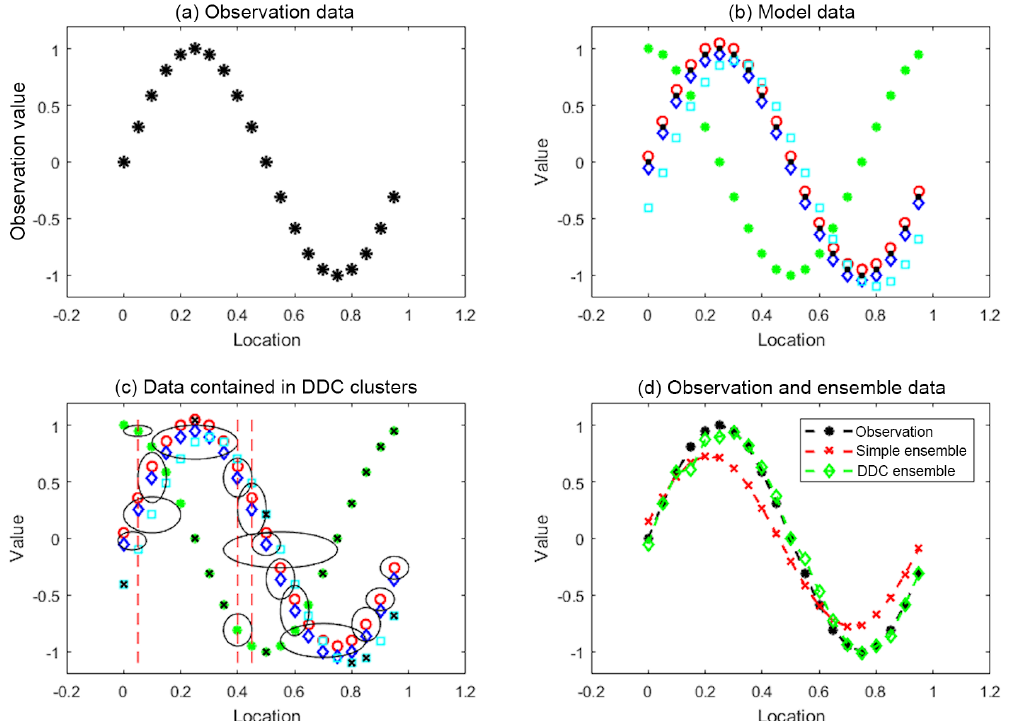
Figure 1. Principles of the ensemble clustering method illustrated using a synthetic data set. (a) A synthetic spatially varying observation (X). (b) Predictions of X from four idealised models (see main text). (c) Cluster analysis of the model data sets using the DDC clustering algorithm. Ellipses represent the different clusters that are formed, and the black crosses are outliers not included in the clusters. (d) Comparison of a multi-model mean (MMM) of X derived from either a simple arithmetic mean of all model data (red) or one based on clusters (green). Observation data from panel (a) are again shown in